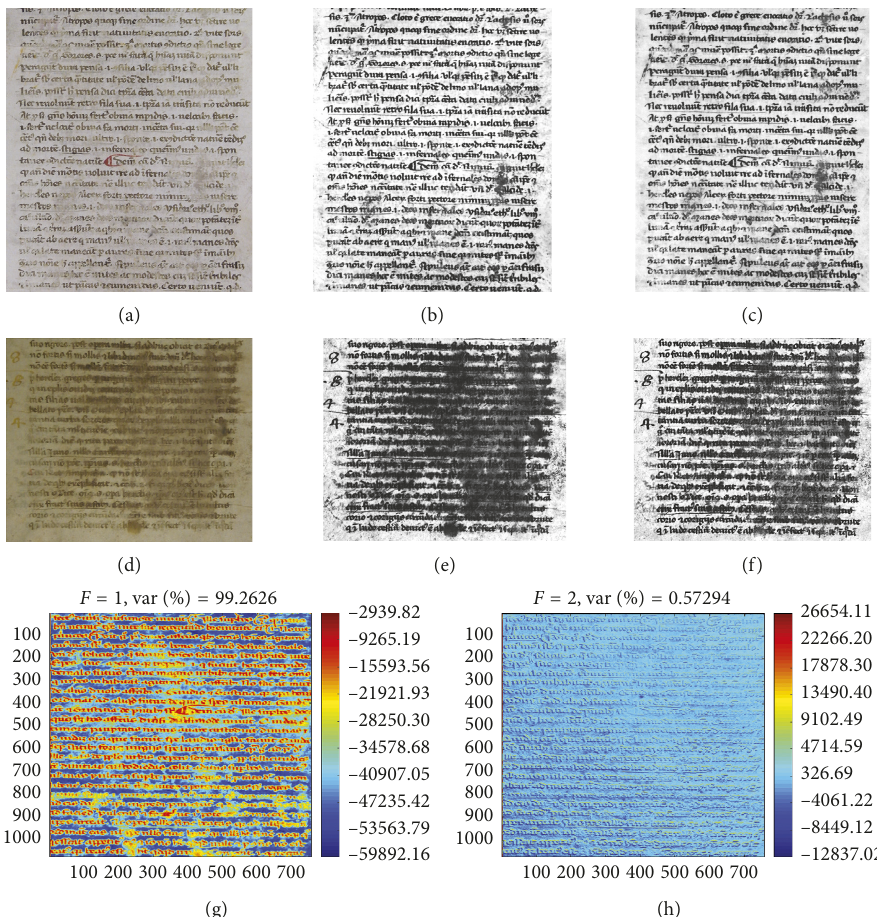
Figure 8: Photography (a, d) and UV fluorescence images taken at 420nm (b, e) and 680nm (c, f) of two details of Parch. 37. (g, h) Image processing results by PCA: score image of PC1 (variance 99.26%) and score image of PC2 (variance